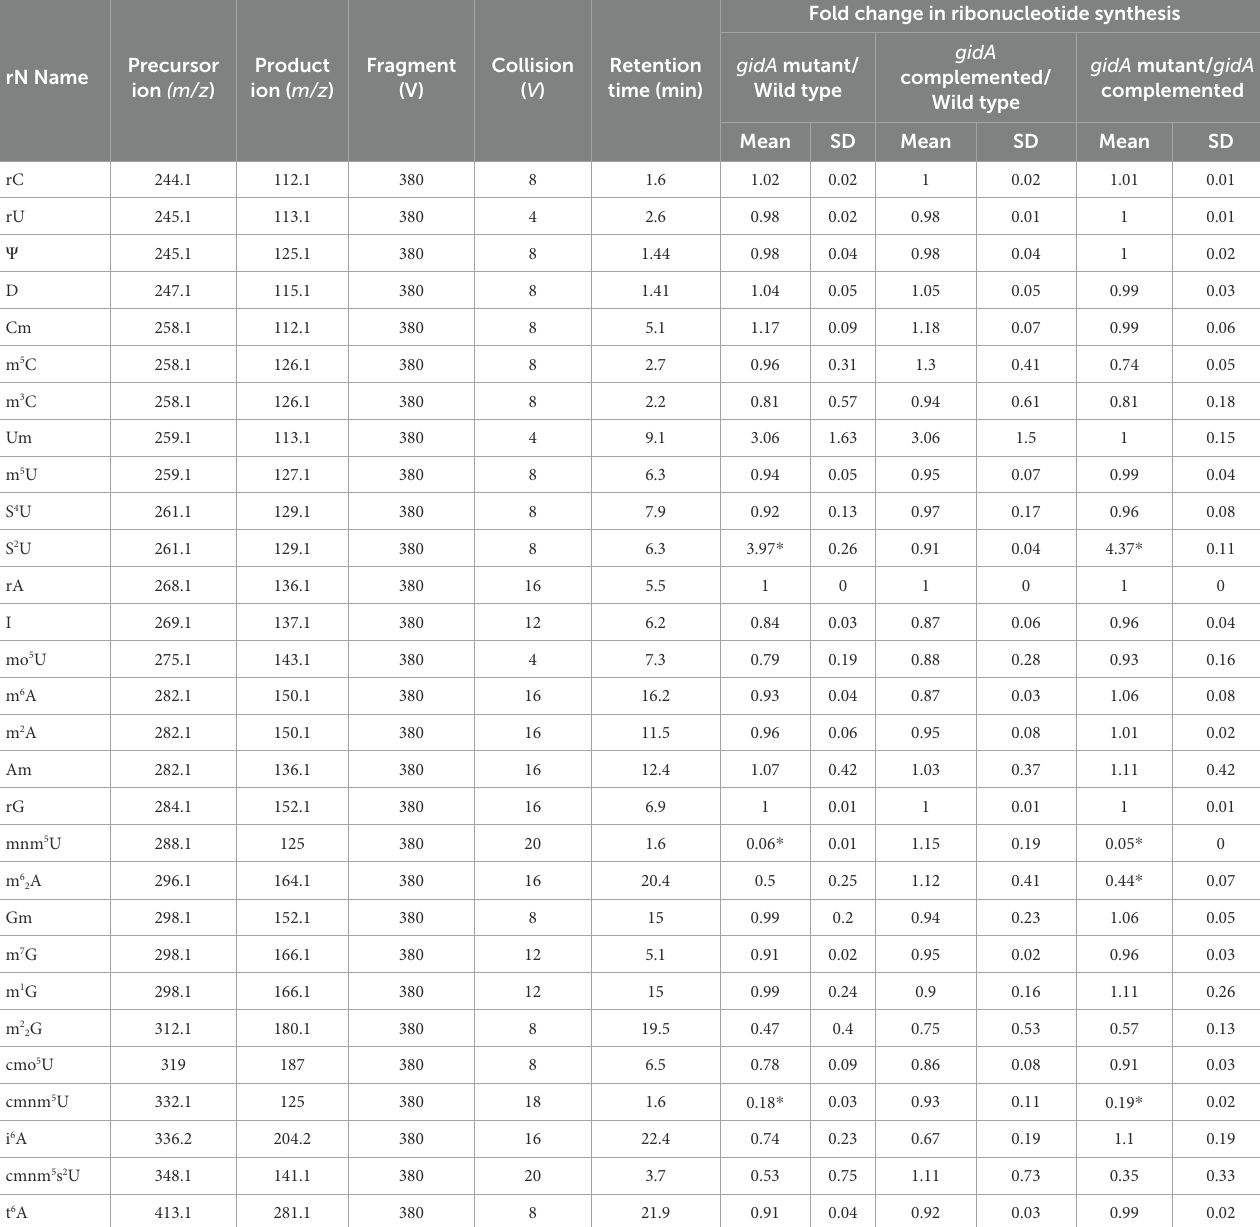
TABLE 2 Ribonucleotides identified by LC–MS/MS analysis of P. aeruginosa PA14 tRNA.